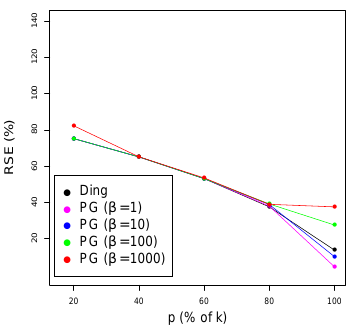
Values of RSE for different values of β obtained by Algorithms 1 and 2 in BION data with n = 100